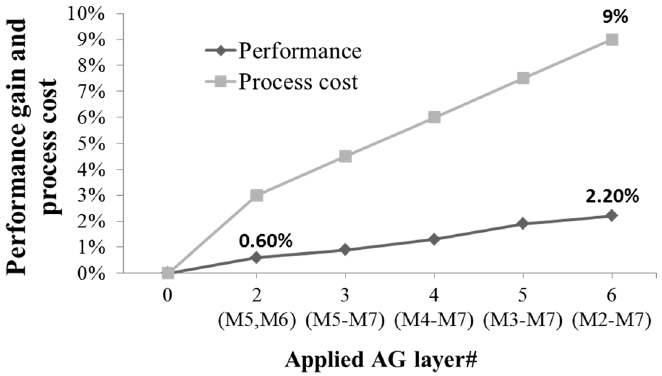
Figure 1. Performance gain and process cost with respect to the number of applied air gap (AG) layers.